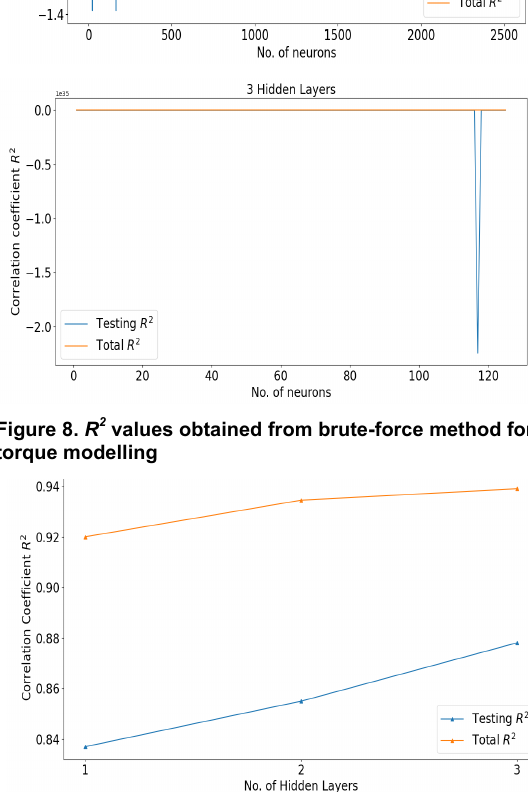
Figure 9. Comparison of R 2 values for different hidden layers for torque modelling